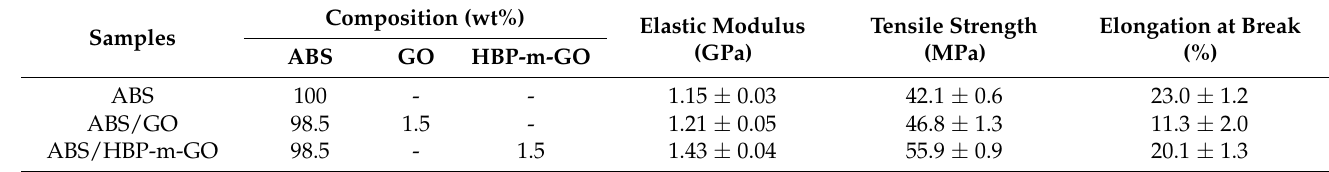
Figure 6. Stress-strain curves of ABS, ABS/GO, and ABS/HBP-m-GO. Table 2. Mechanical parameters of ABS, ABS/GO, and ABS/HBP-m-GO.